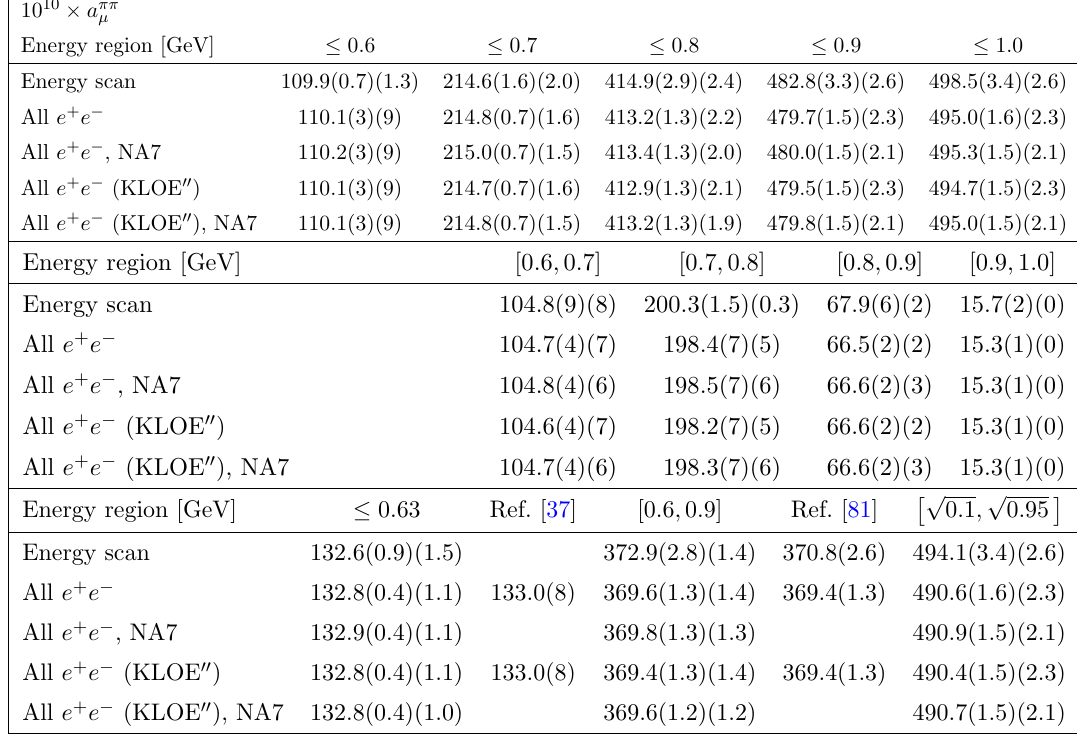
Table 12. Values for a (cid:25)(cid:25) from our (cid:12)nal (cid:12)ts to combinations of data sets. The (cid:12)rst error is the (cid:12)t (cid:22) p uncertainty, in(cid:13)ated by (cid:31) 2 = dof, the second error is the combination of all systematic